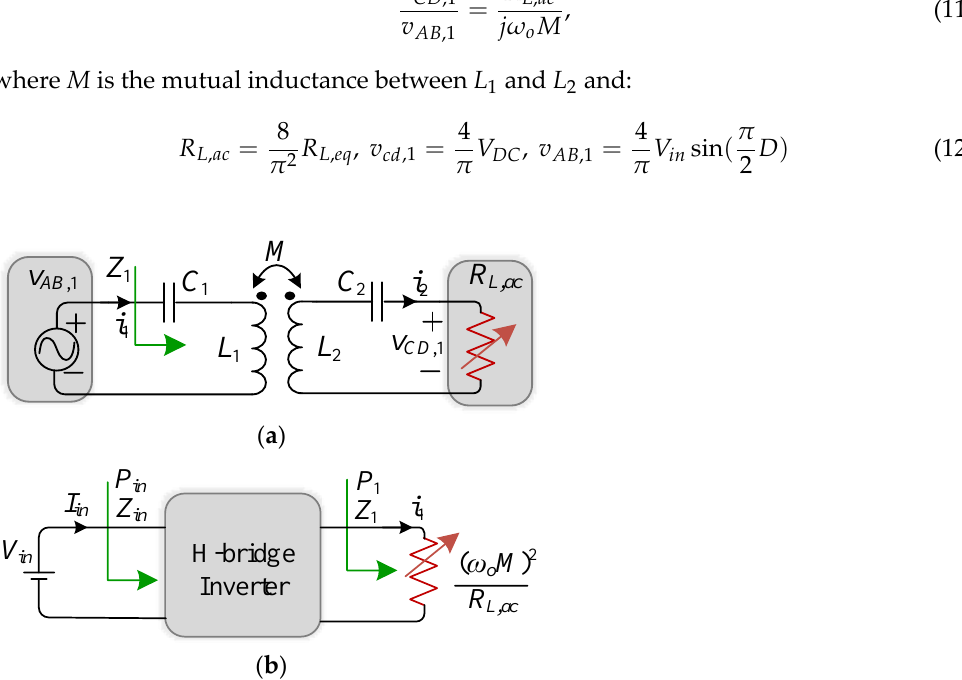
Figure 4. WPTS with the equivalent load.